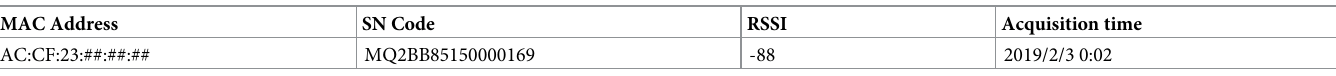
Table 2. Data format after desensitization.